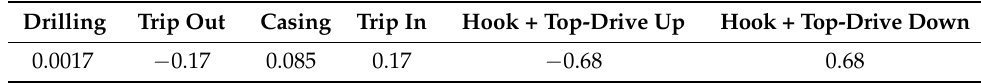
Table 3. PSU overall speed ratio for each drilling process phase.